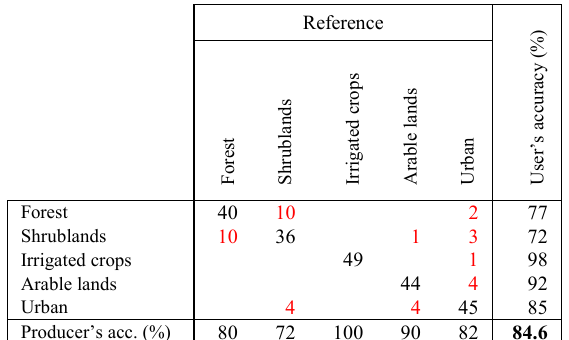
Table 1. Confusion matrix of the classification using spectral features from Landsat 7 ETM+ data.